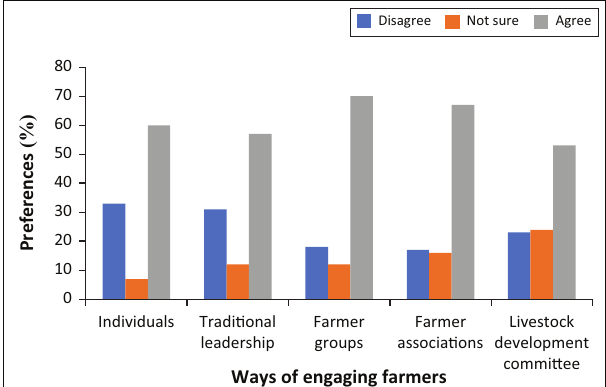
FIGURE 2: Farmer engagement